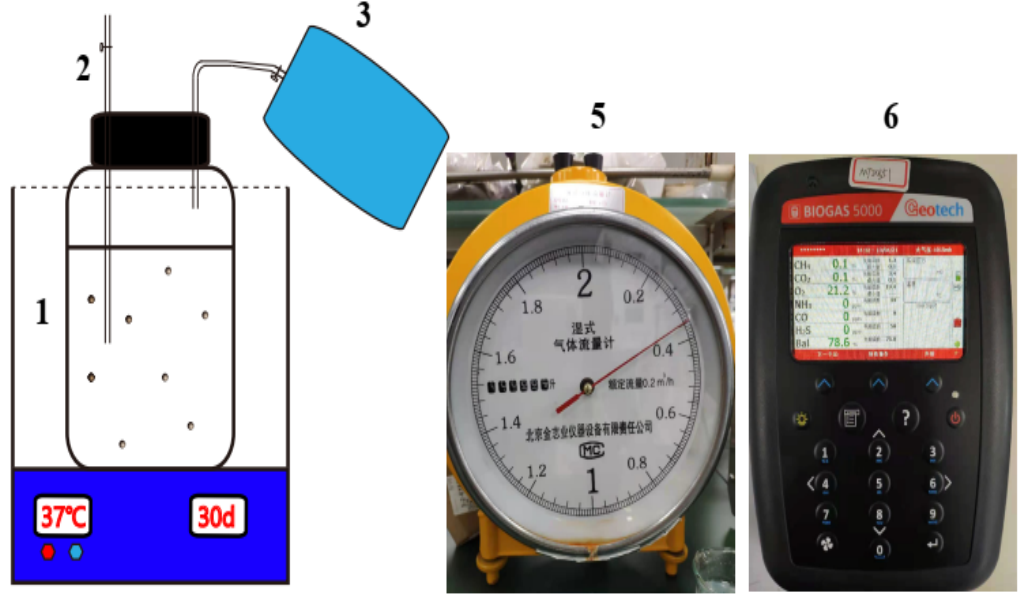
Figure 1. The batch anaerobic digestion reactor. (1. Anaerobic digestion reactor; 2. Sampling port; 3. Methane collection bag; 4. Water bath; 5. Gas flow meter; 6. Methane